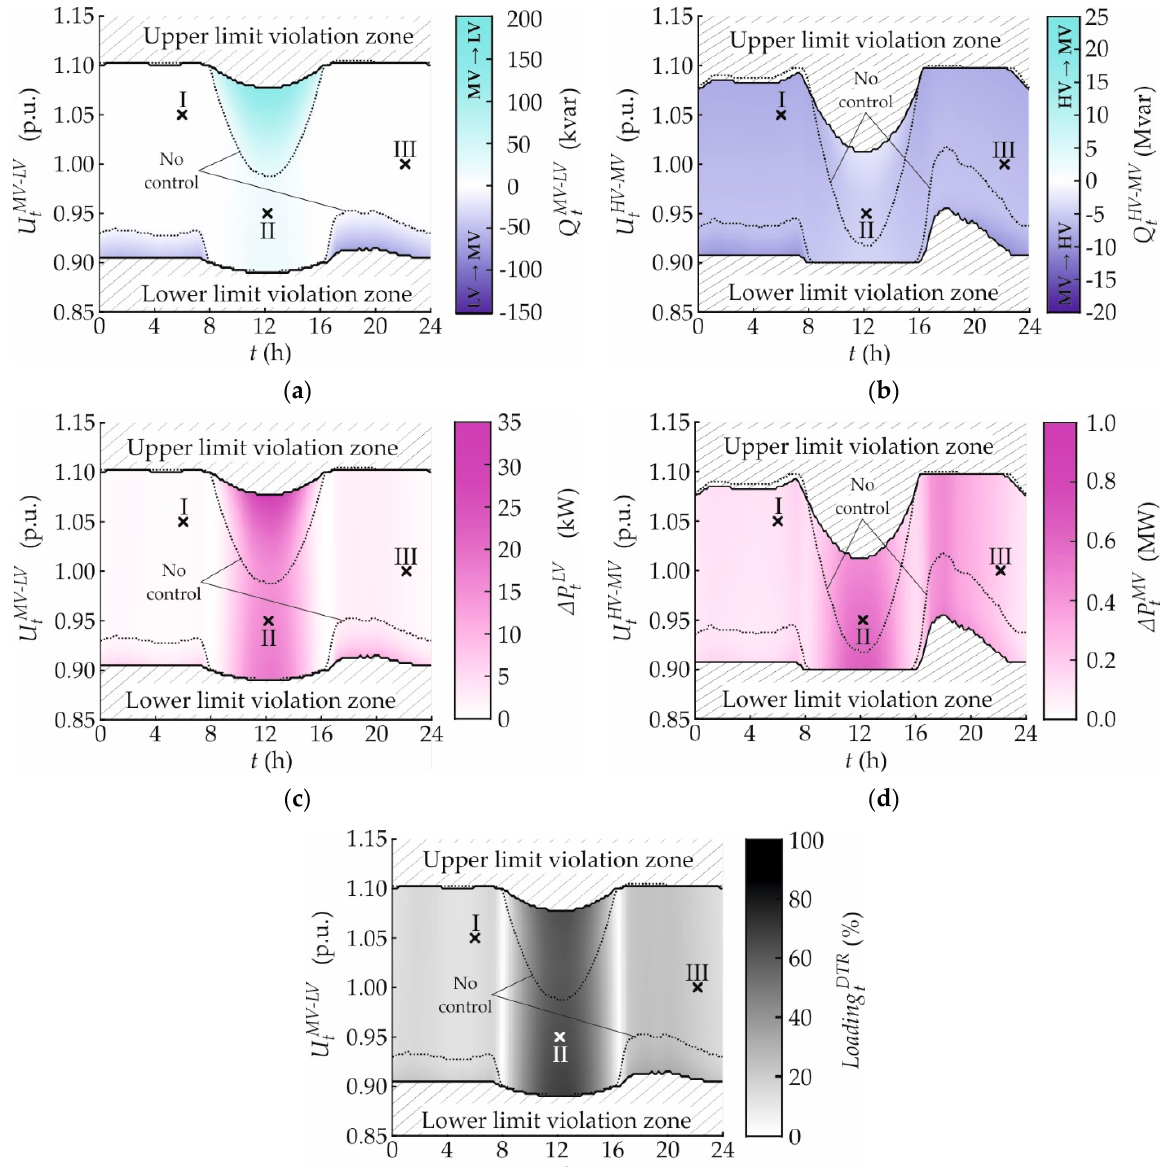
Figure 20. Daily behavior of the test link chain for various boundary voltages, the X ( U ) local control, and CP_ Q -Autarky: ( a ) reactive power exchange over the MV − LV boundary (rural LV_Link-Grid); ( b ) reactive power exchange over the HV − MV boundary; ( c ) active power loss within the rural LV_Link-Grid; ( d ) active power loss within the MV_Link-Grid; ( e ) DTR loading (rural LV_Link-Grid).